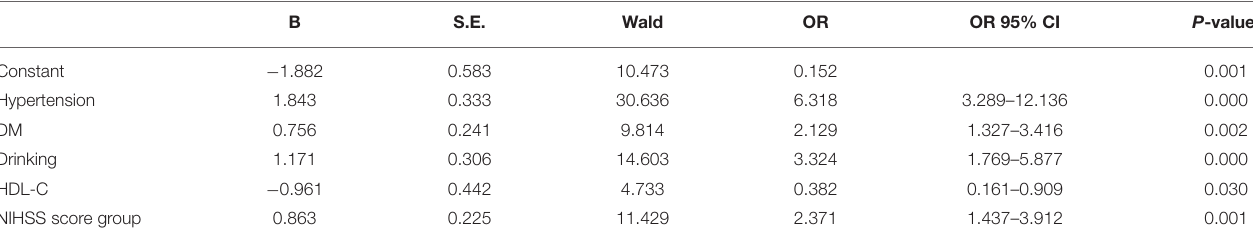
TABLE 4 | Multivariate logistic regression analyses of the risk factors associated with post-stroke anxiety (PSA) evaluated by Hospital Anxiety and Depression Scale (HADS-A) scale. B